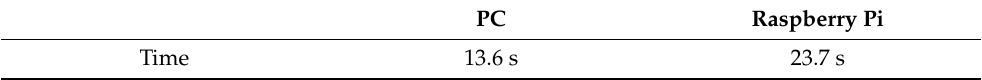
Table 3. Tezos basic operations execution time (for a 1000 fingerprints